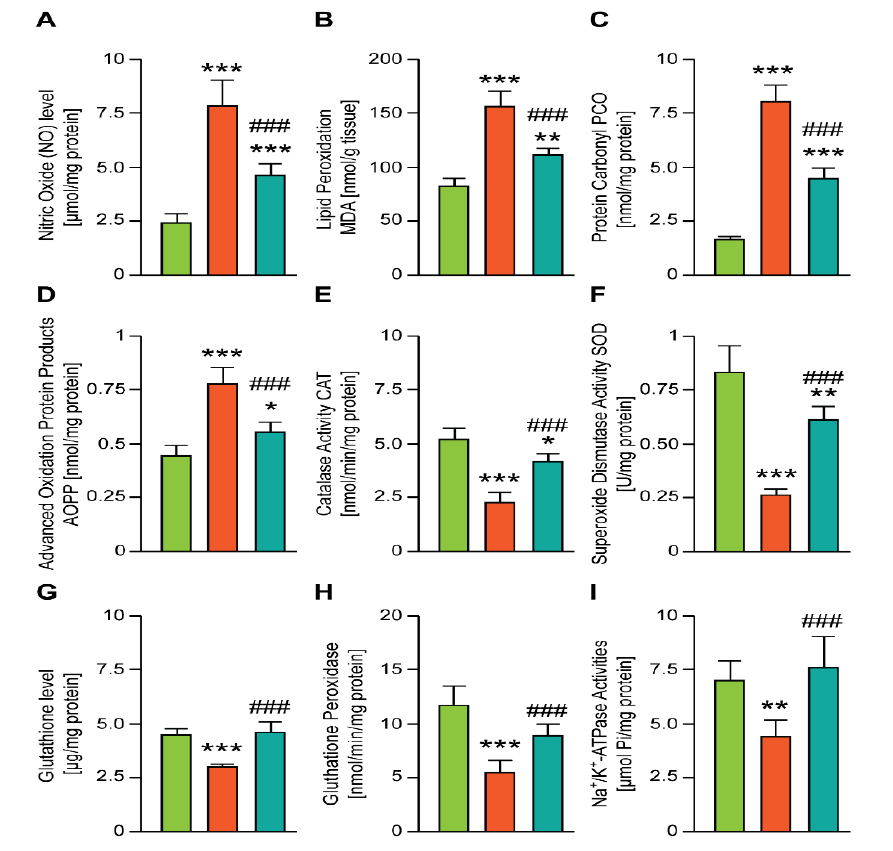
Figure 2. In vivo study and oxidative stress assessment. ( A – D ) Effect of polyphenol combination on kidney CAT, SOD, GPx, and Na + -K + -ATPase activities and GSH levels, in STZ-induced diabetic rats. ( E – I ) Effect of polyphenol mix on kidney CAT, SOD, GSH levels, GPx activity, and Na + -K + -ATPase activities in STZ-induced diabetic rats. Data are expressed as means ± SEM. *** p < 0.001, ** p < 0.01, * p < 0.05 when the STZ-induced diabetic rats is compared to control group; ### p < 0.001 when NCQ-STZ treated rats are compared to STZ group.